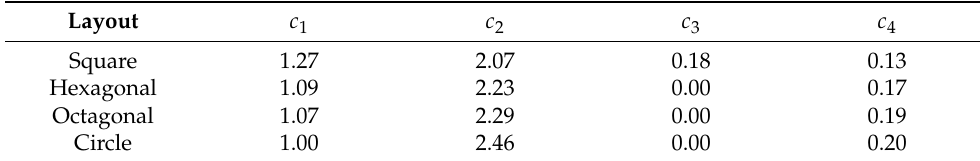
Table 1. Coefficients for various